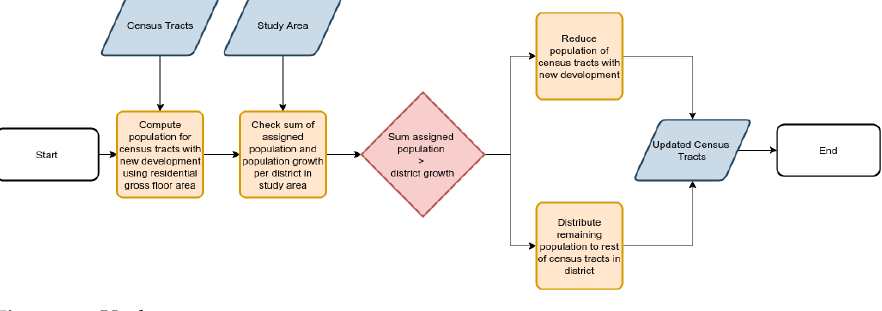
Figure 12. Update census